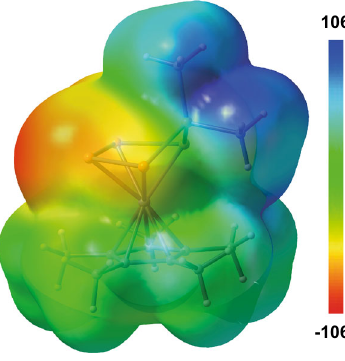
Fig. 4 Electrostatic potential mapped on electron density (isovalue = 0.001) for 3c. Colour code (blue = positive, red = negative) in kJ·mol − 1